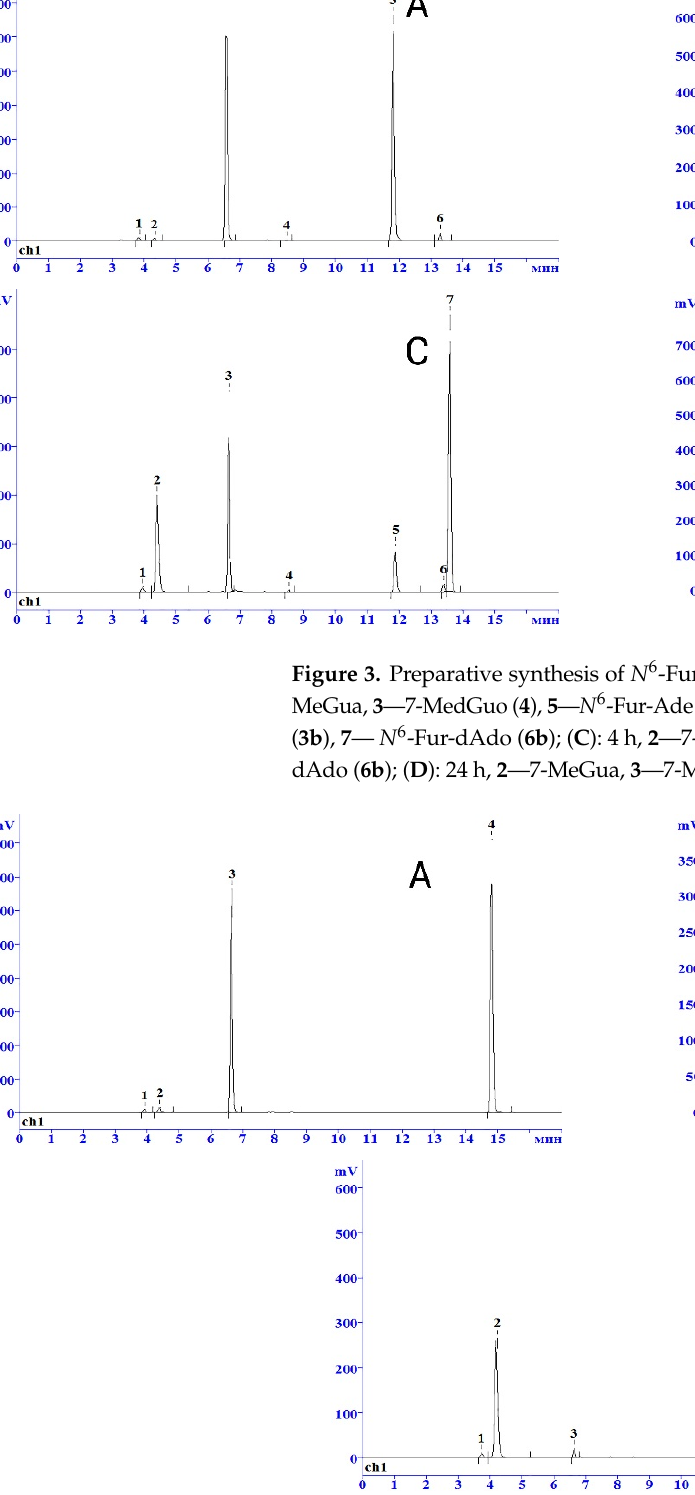
Figure 4. Semi-microscale synthesis of N 6 -Bn-2-NH 2 -dAdo ( 6c ) using transglycosylation reaction. ( A ): t0, 2 – 7-MeGua; 3– 7-MedGuo ( 4 ), 4 – N 6 -Bn-2-NH 2 -Ade ( 3c ); ( B ): 1 h, 2 –7-MeGua, 3 –7-MedGuo ( A ): t0, 2 —7-MeGua; 3— 7-MedGuo ( 4 ), 4 — N 6 -Bn-2-NH 2 -Ade ( 3c ); ( B ): 1 h, 2 —7-MeGua, 3 —7- ( 4 ), 4 – N 6 -Bn-2-NH 2 -Ade ( 3c ), 5 – N 6 -Bn-2-NH 2 -dAdo ( 6c ); ( C ): 20 h, 2 –7-MeGua, 3 –7-MedGuo ( 4 ), 4 – MedGuo ( 4 ), 4 — N 6 -Bn-2-NH 2 -Ade ( 3c ), 5 — N 6 -Bn-2-NH 2 -dAdo ( 6c ); ( C ): 20 h, 2 —7-MeGua, 3 —7- N 6 -Bn-2-NH 2 -dAdo ( 6c ). MedGuo ( 4 ), 4 — N 6 -Bn-2-NH 2 -dAdo ( 6c